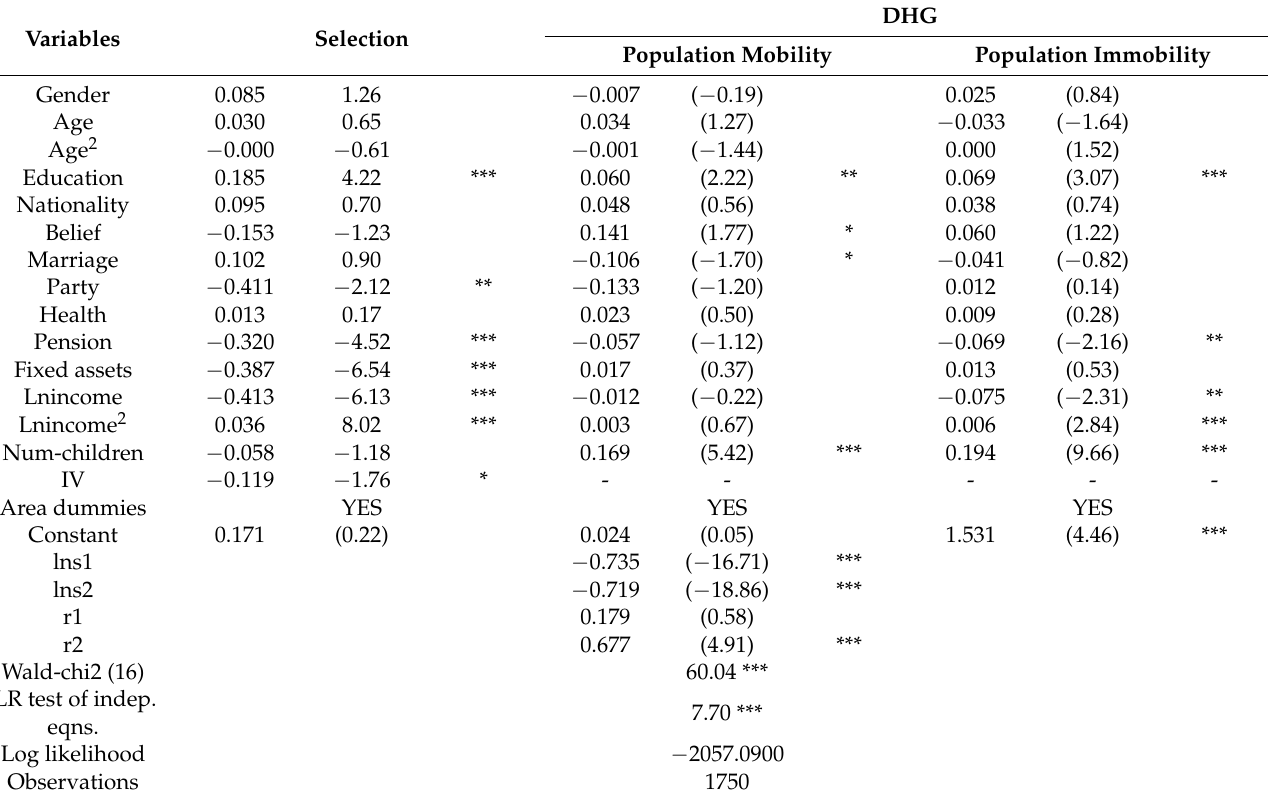
Table 6. The estimates for the determinants of RPM and DHG.